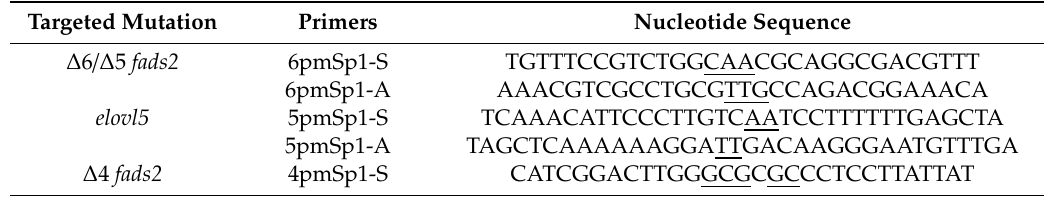
Table 4. Primers used for site-directed mutations of Sp1 binding sites.